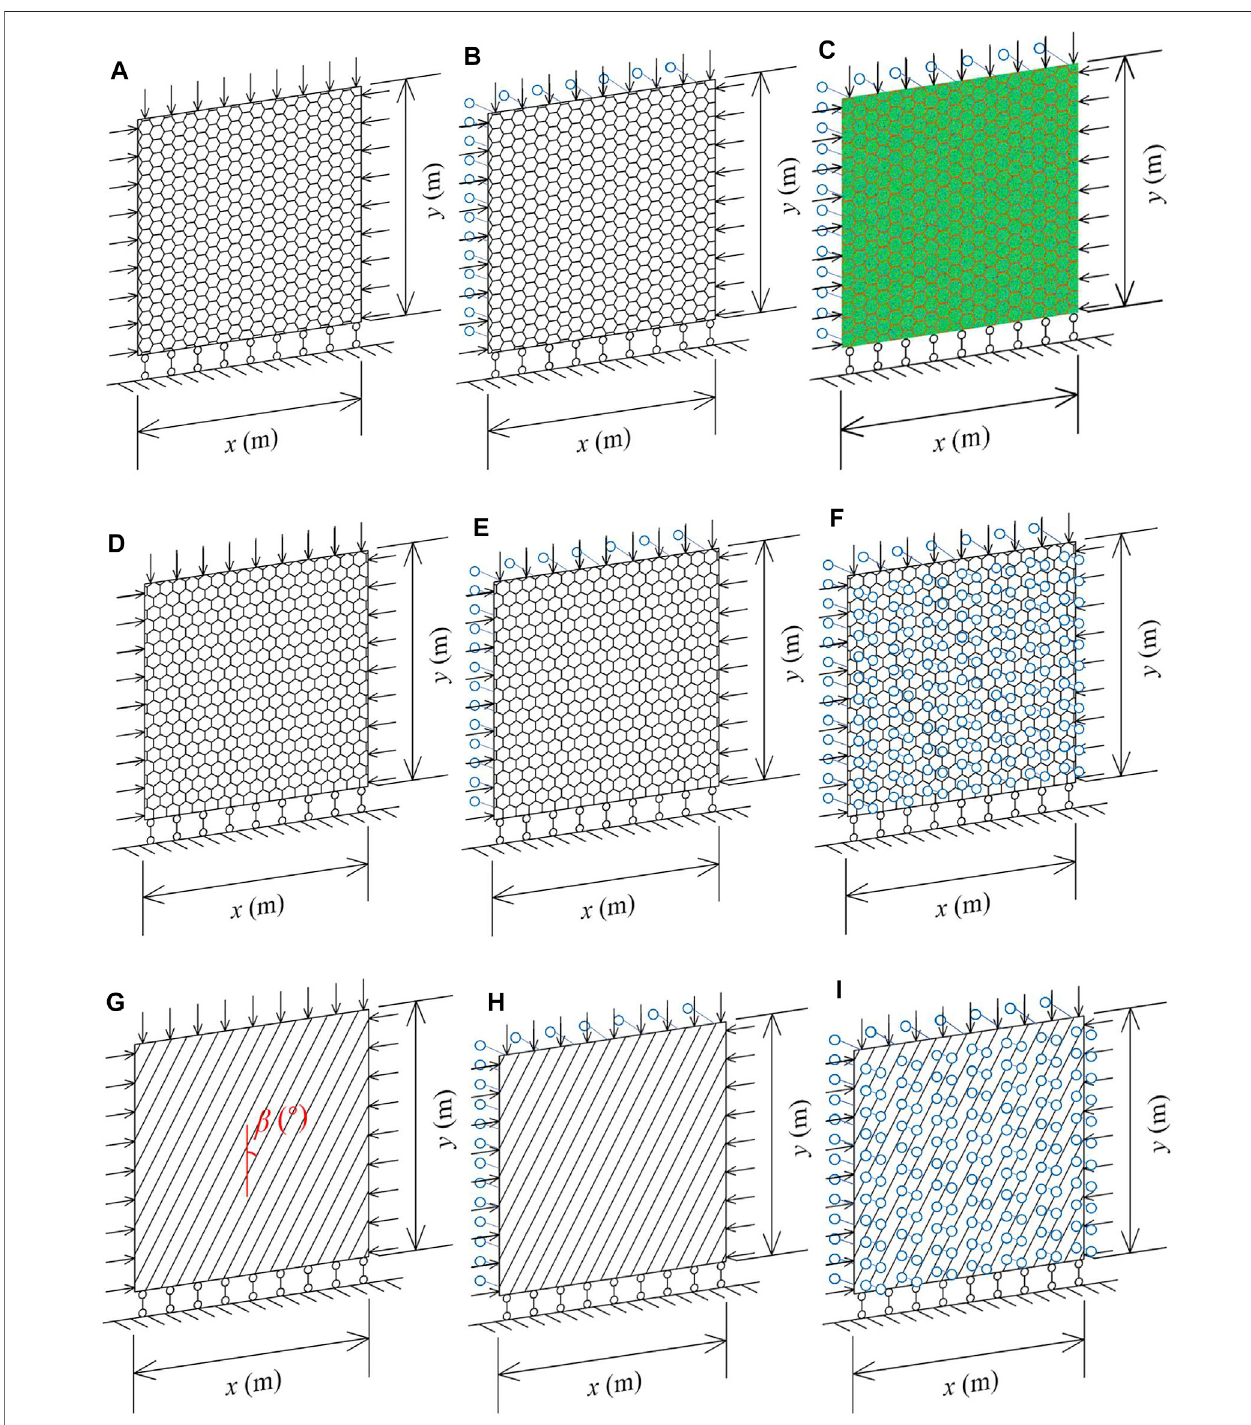
FIGURE 4 | Typical settings and boundary conditions of the numerical test of columnar jointed basalts (CJBs) with different model boundaries and con fi ning pressures. (A) Thecaseofplanestress,directionIorthogonaltothecolumnaxis. (B) Thecasebetweenplanestressandplanestrain,directionI. (C) Schematicdiagram of transforming the CJB images into the numerical model of CJBs. (D) The case of plane stress, direction II orthogonal to the column axis. (E) The case between plane stress and plane strain, direction II. (F) The case of plane strain, direction II. (G) The case of plane stress, the direction parallel to the column axis. (H) The case between plane stress and plane strain, the direction parallel to the column axis. (I) The case of plane strain, the direction parallel to the column axis.